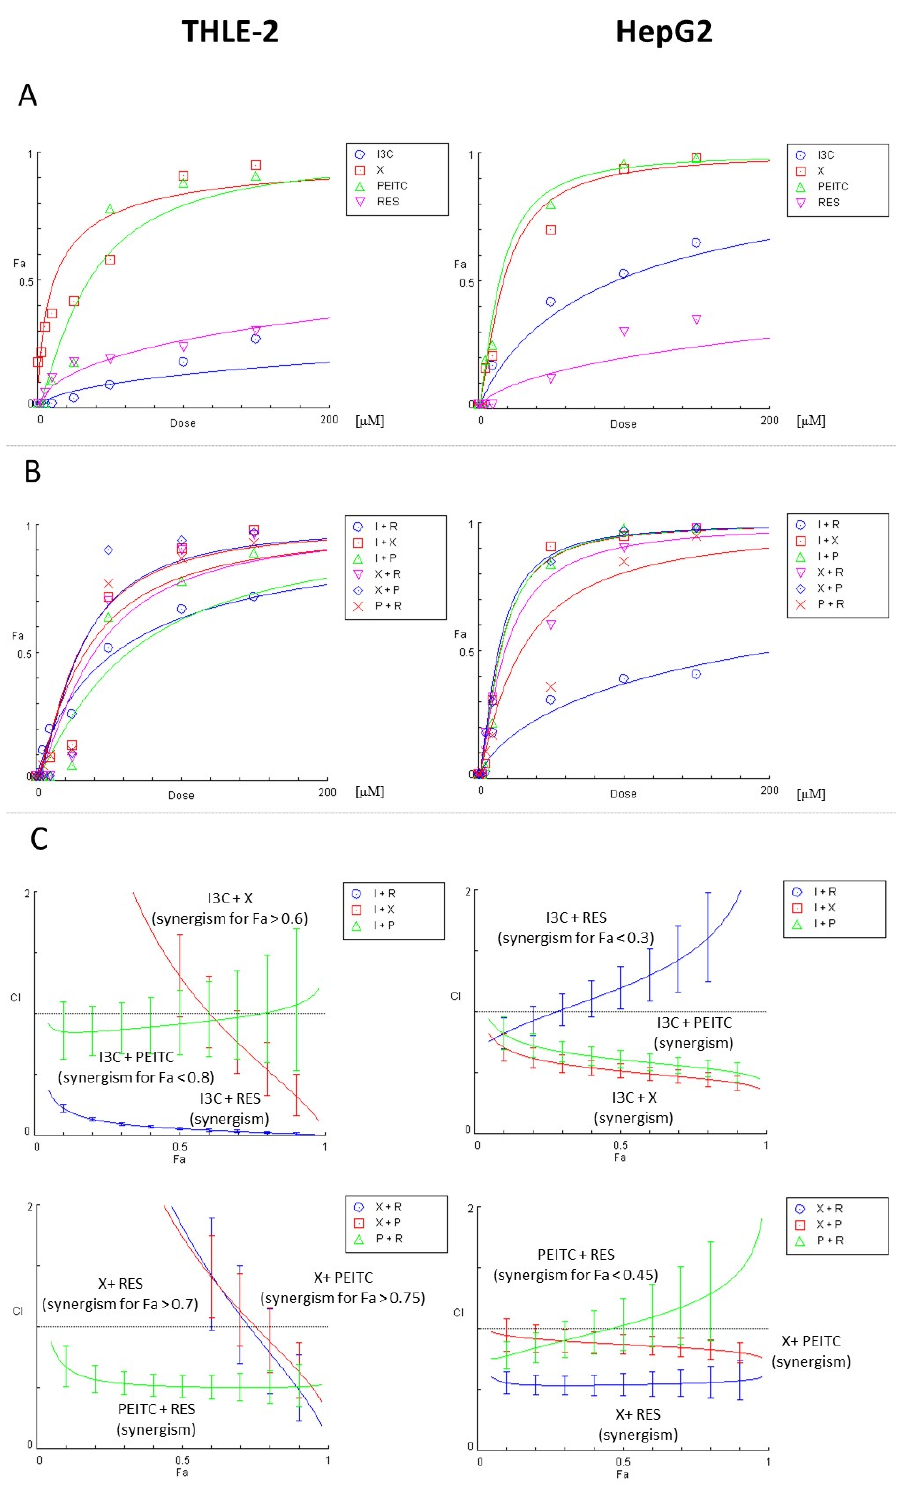
Figure 3. The results of the analysis of the combinatorial effects of the studied compounds on cell viability by MTT assay. THLE-2 and HepG2 cells were treated with increasing concentrations (0.5–150 µ M) of the individual chemicals and their combinations for 24 h. Control cells were treated with vehicle (DMSO). Mean values from three independent experiments were used in calculations using CompuSyn software. Dose-effect curves for individual compounds (panel A ) or their combinations (panel B ) were generated. (Panel C ) The evaluation of the combination index (CI) for the assessment